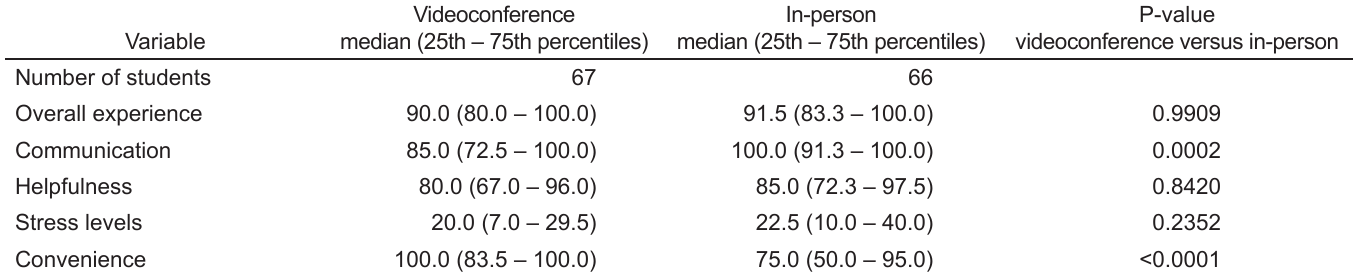
Table 2. Comparison of participant ratings in individuals randomized to videoconference compared to in-person meetings for their mid- clerkship feedback